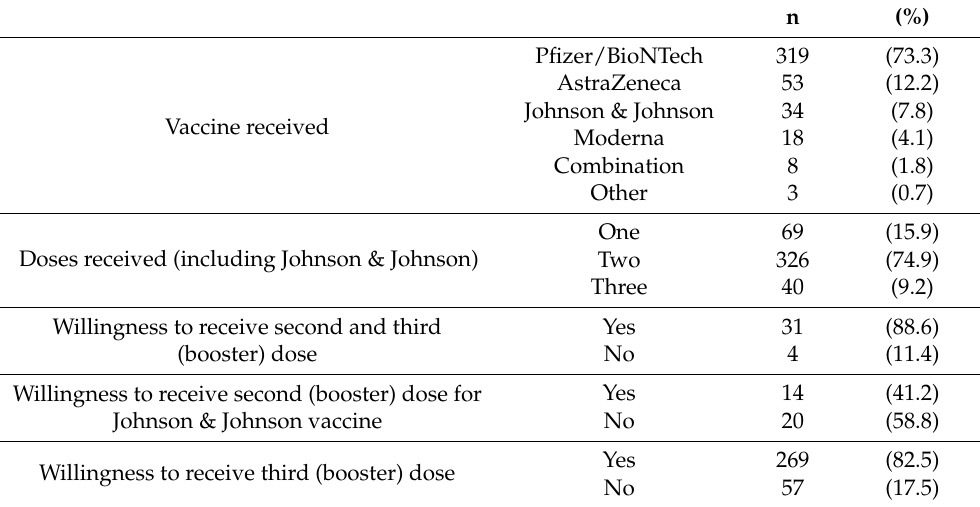
Table 3. Description of vaccine type, the number of doses, and the willingness to receive a second or third dose (n =